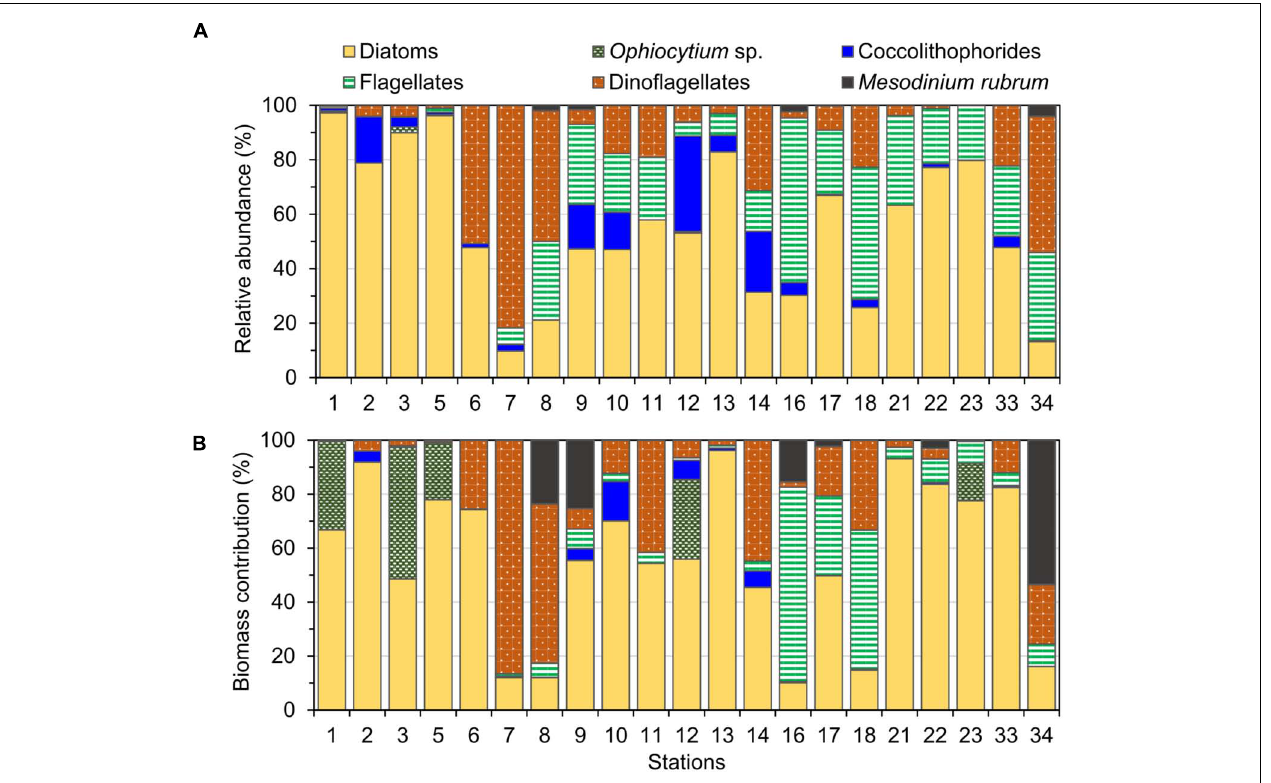
FIGURE 4 | Relative (A) abundance and (B) biomass of the main phytoplankton groups identified at the study stations in September